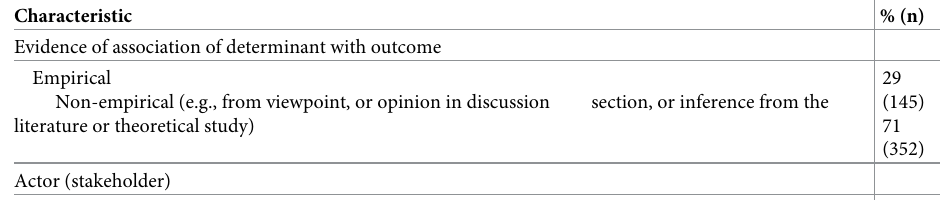
Table 2. Characteristics of the determinants (n = 497), outcomes and their